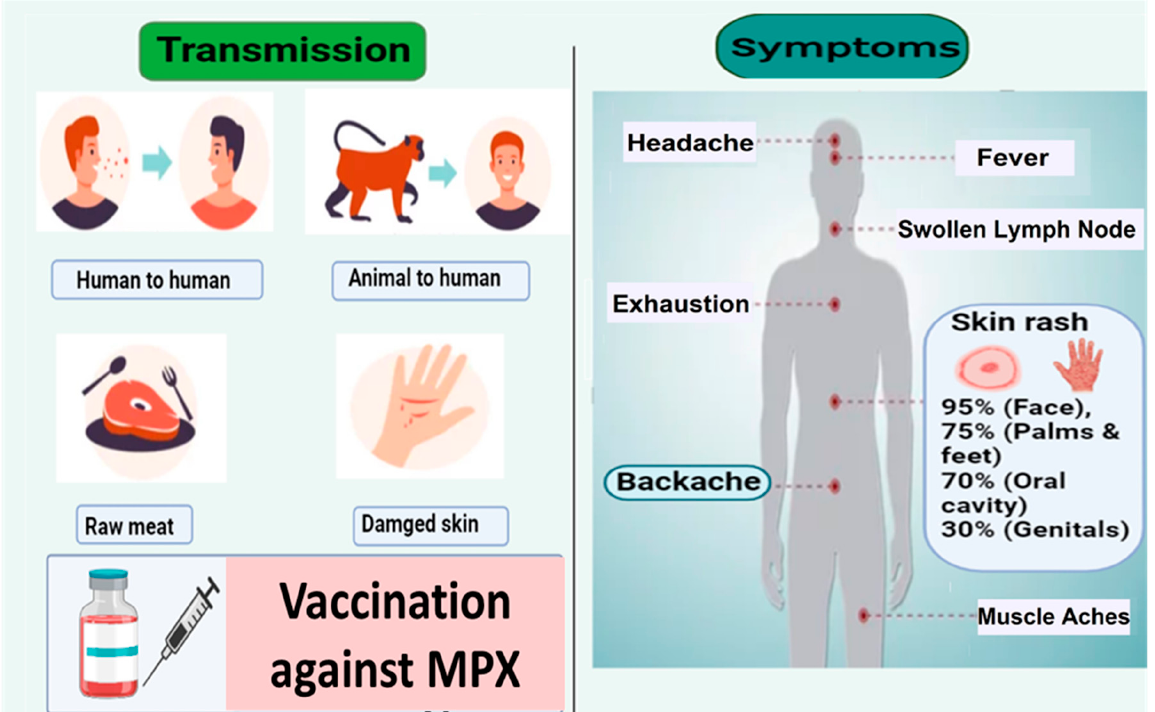
Figure 1. Symptoms, transmission, and treatment of MPXV. Common symptoms include chills, fever, swollen lymph nodes, muscle pain, tiredness, back pain, and rashes. Infected wild animals, raw meat, bites, scratches, and sex without protection, especially men with men, are known as the primary transmission methods, whereas secondary transmission from contaminated substances also occurs.